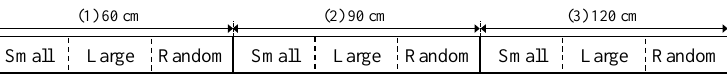
Figure 2. Experimental